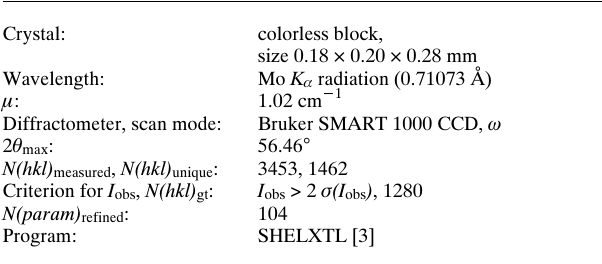
Table 1. Data collection and handling.